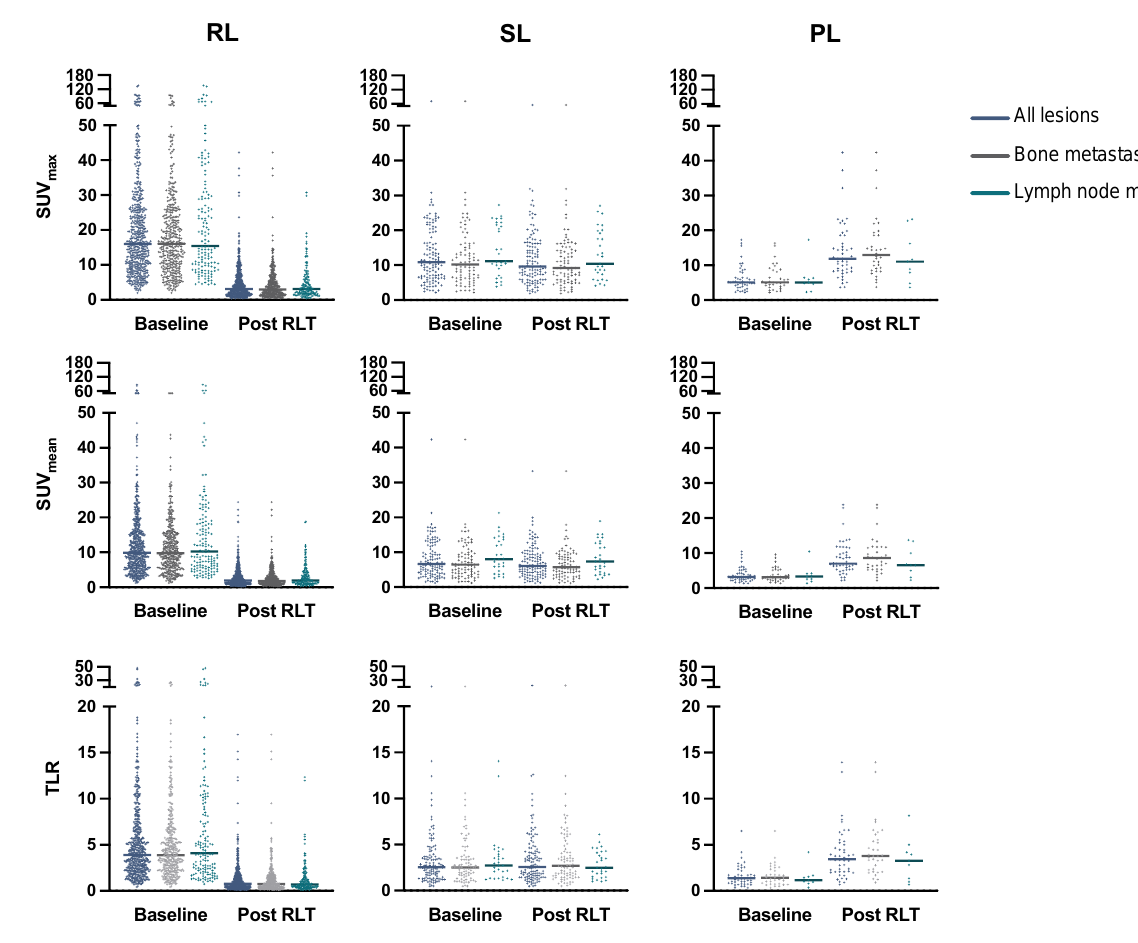
Figure 1. Change in SUV max , SUV mean , and TLR in all lesions, and in bone/lymph node metastases subgroups with median values (line). RL: responding lesions, SL: stable lesions, PL: progressive lesions, RLT: radioligand therapy, SUV: standardized uptake value, TLR: tumor-to-liver ratio. The course of all lesions per patient is depicted in Figure 3. In 11 patients showing lesion response in included baseline tumor sites, ≥ 2 new onset lesions on posttherapeutic imaging led to discontinuation of RLT. Examples of intraindividual lesion response on [ 68 Ga]Ga-PSMA-11 PET/CT imaging are provided in Figures 4 and